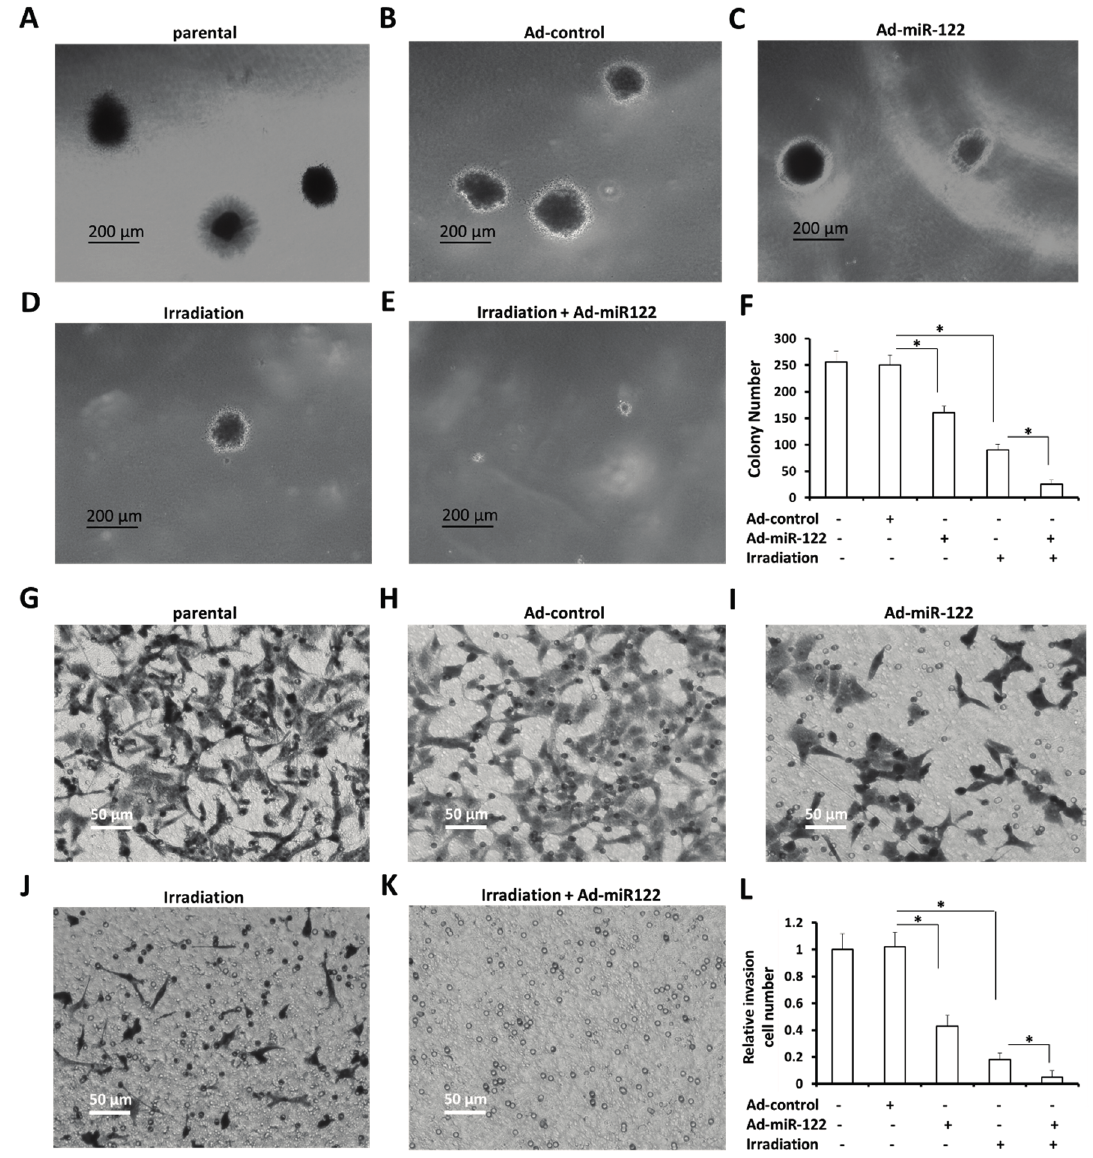
Figure 4. Expression of miR-122 promotes the inhibitory activity of irradiation on A549 cells anchorage-independent growth and invasion. ( A – E ) A549 cells, infected with Ad-control or Ad-miR-122, were then treated with or without 6 Gy irradiation. Then, the soft-agar assay was performed. The results were shown as typical photograph ( A – E ) or colony number (mean ± SD) from triplicate experiment with similar results ( F ); ( G – K ) A549 cells, infected with Ad-control or Ad-miR-122 were then treated with or without 6 Gy irradiation. Then, the transwell assay was performed. The results were shown as typical photograph ( G – K ) or relative invasion cell number (mean ± SD) from triplicate experiment with similar results ( L ). * p < 0.05 versus control or miR-122, * p < 0.05 versus without or with 6 Gy